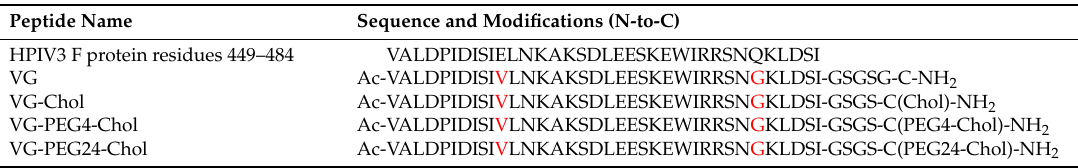
Table 1. HPIV3 HRC derived peptide sequences. The residues highlighted in red were modified from the original HPIV3 F